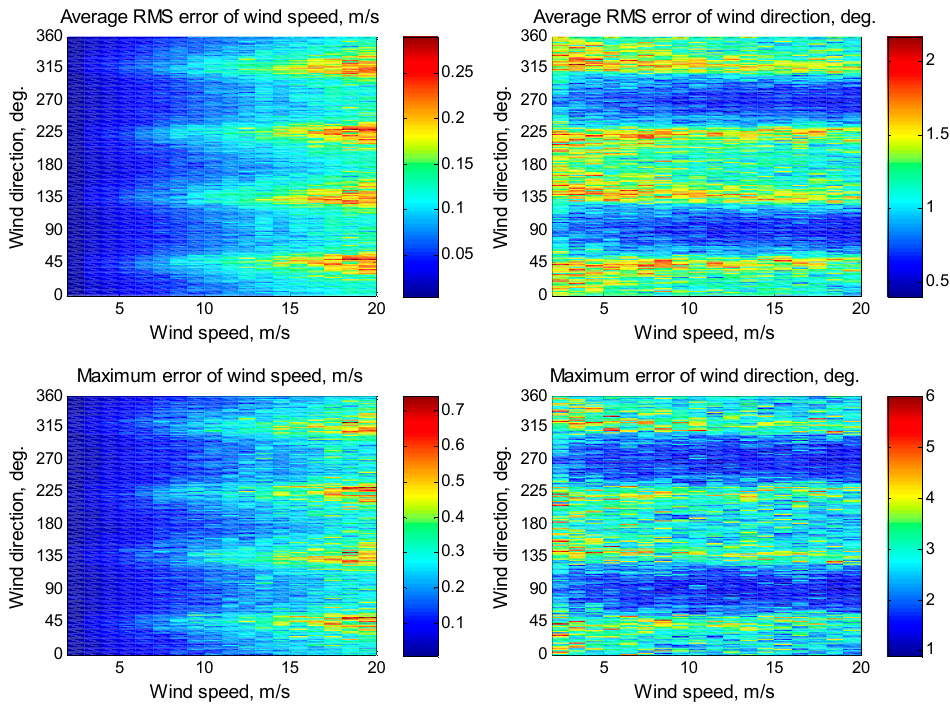
Figure 11. Simulation results for the mounting angle of a beam axis in the horizontal plane of 30° without instrumental noise at wind speeds of 2–20 m/s for the incidence angle of 45° with 1565 averaged NRCS samples for each azimuthal angle.